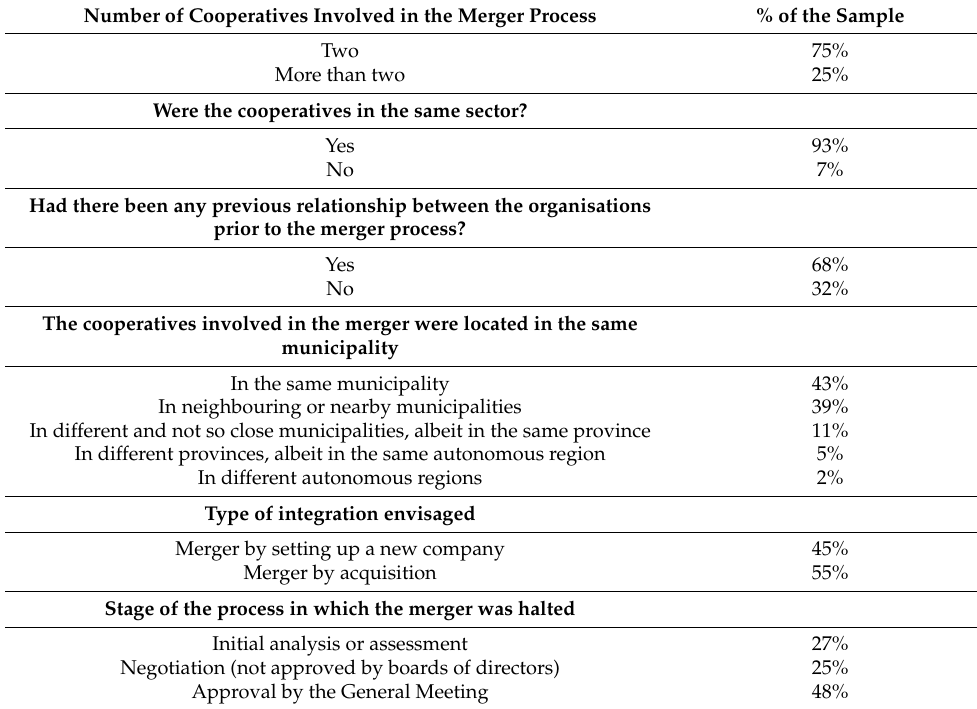
Table 4. Merger process